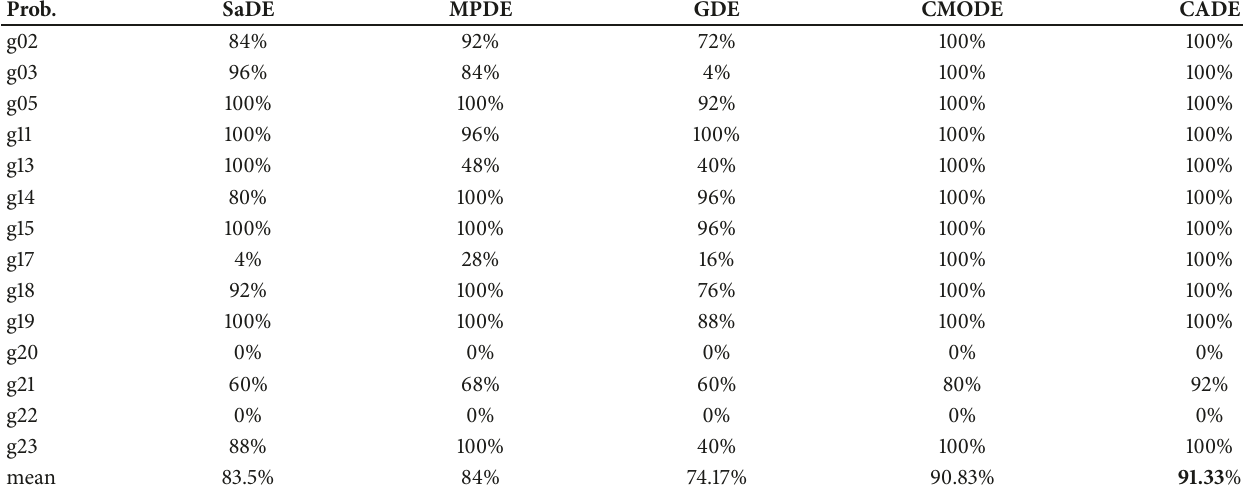
Table 7: Comparison of CADE with SADE, MPDE, GDE, and CMODE in terms of success rate.